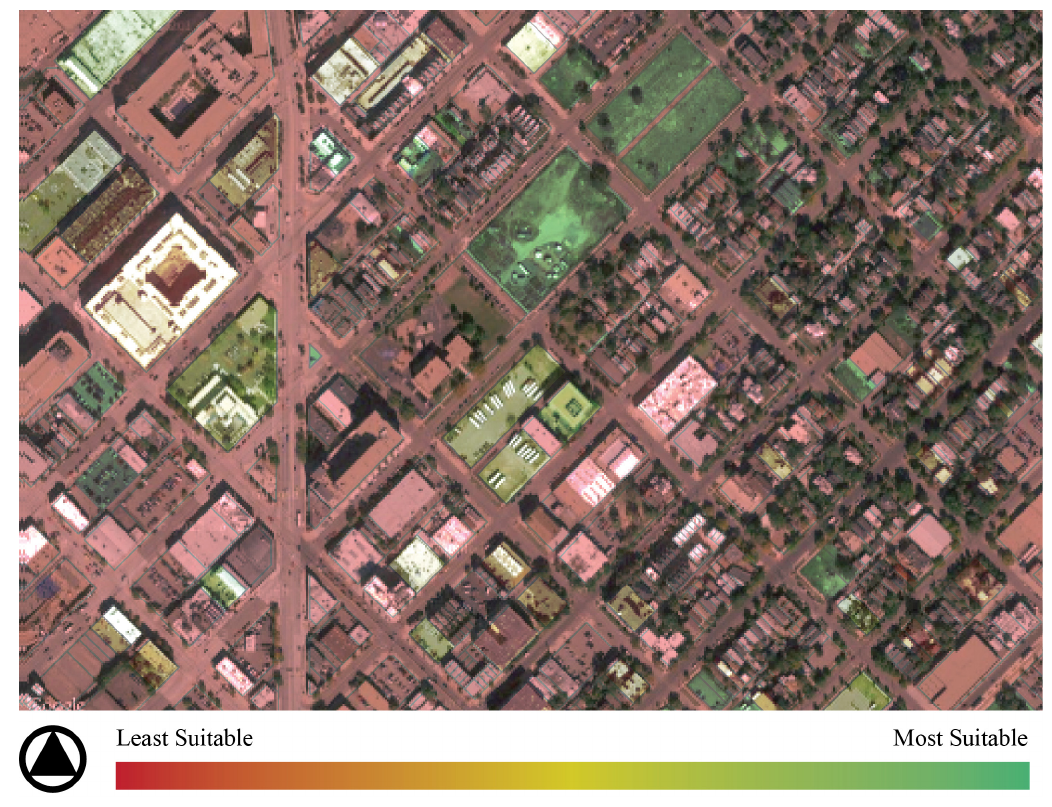
Figure 3. Example of suitability analysis for a highly intimate park with informal play spaces.